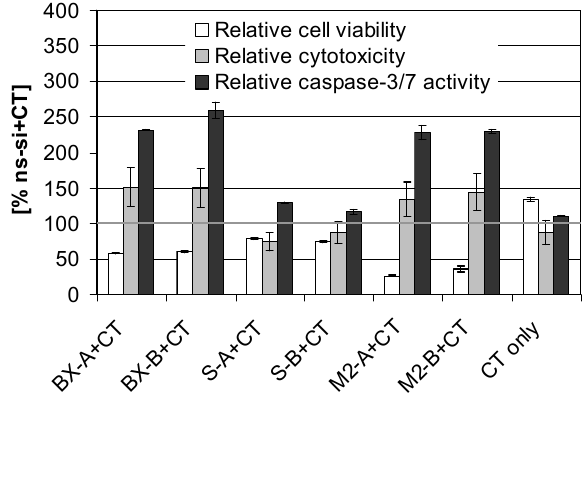
Figure 7. Analyses of cell viability, cytotoxicity and caspase-3/7 activity after treatment of EJ28 cells with siRNAs and subsequent chemotherapy (CT). Cells were transfected with the respective siRNAs for four hours. “CT only” cells were treated with serum-free OptiMEM medium during transfection. Twenty-four hours after transfection start, cells were treated with 0.9 µg/mL mitomycin C for two hours. ApoTox-Glo triplex assay was performed 72 h after transfection. Values shown are mean values of duplicates and are relative to the control siRNA “ns-si” plus CT treatment